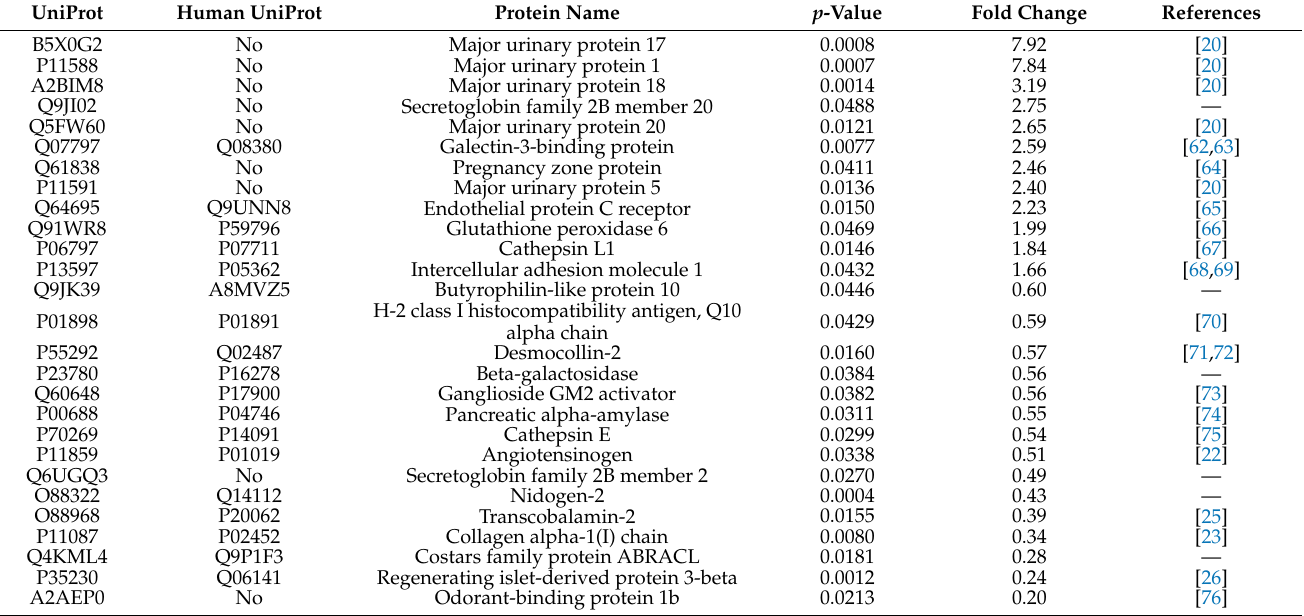
Table 1. Details of differential proteins between week 1 and week 0 samples in the experimental group.